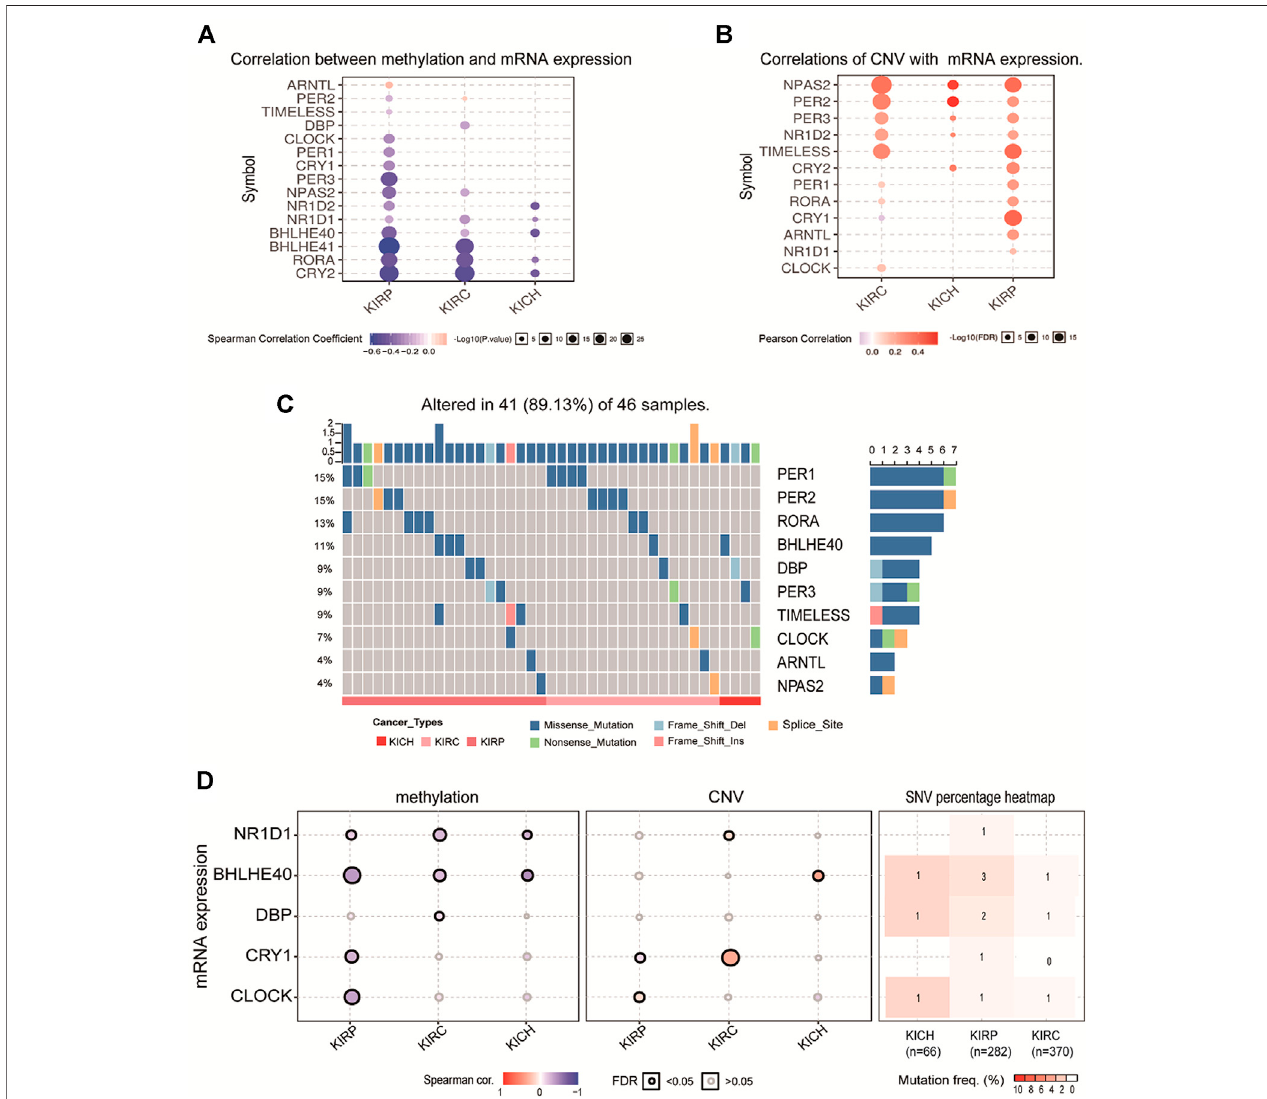
FIGURE 5| The methylation level, CNV and mutation ofclock control genes in pan-RCC. (A) Correlation between methylation and mRNA expression in pan-RCC. Here, the blue dots indicate a negative correlation of methylation with mRNA expression, pink dots represent positive correlation, and larger dots con fi rmed stronger methylation correlation with mRNA expression. (B) Correlation of CNV with mRNA expression in pan-RCC. The darker the pink dot indicates a stronger correlation of CNV associated with mRNA expression. FDR < 0.05. (C) The mutation distribution of rhythm genes in pan-RCC. Here, the columns represent the number of case mutations in patient rhythmic genes, the rows represent rhythmic genes, and the color bars below the fi gure represent three different types of renal cancer. (D) The methylation level, CNV, and mutation of fi ve key differentially expressed genes.